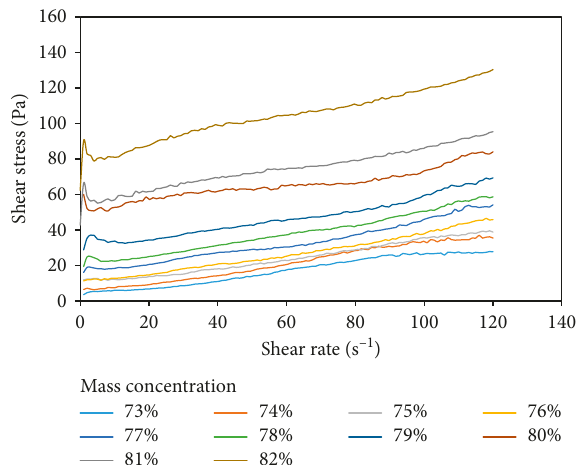
Figure 2: Relationship between shear stress and shear rate of different slurry mass